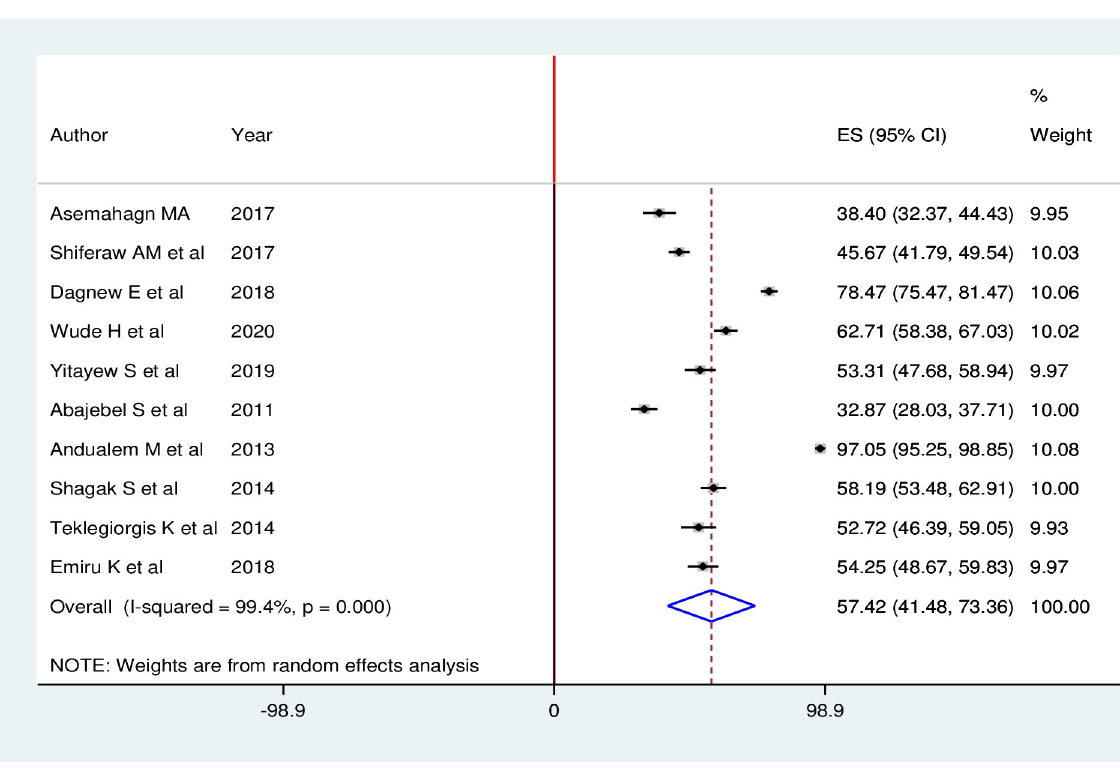
Fig 2. Forest plot of the pooled utilization of routine health information among health workers in Ethiopia, 2020.